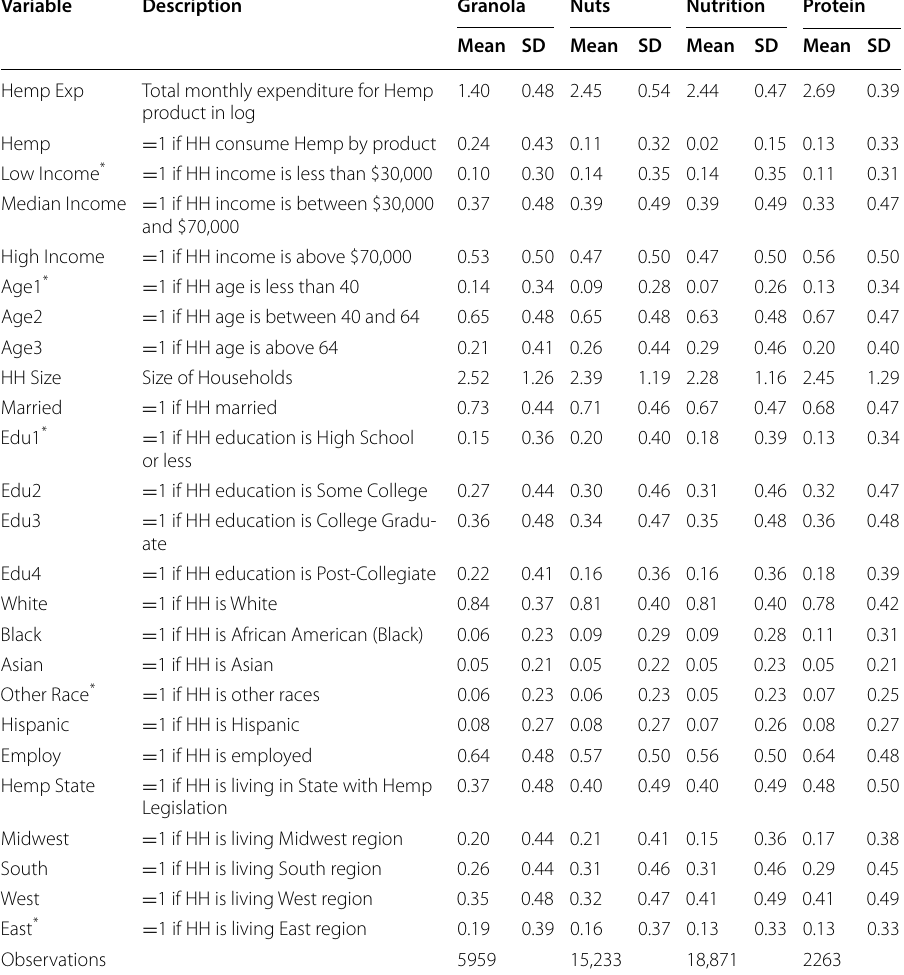
S.D represents the standard deviation. HH represents the head of household. A variable with an asterisk symbol represents a reference (base)